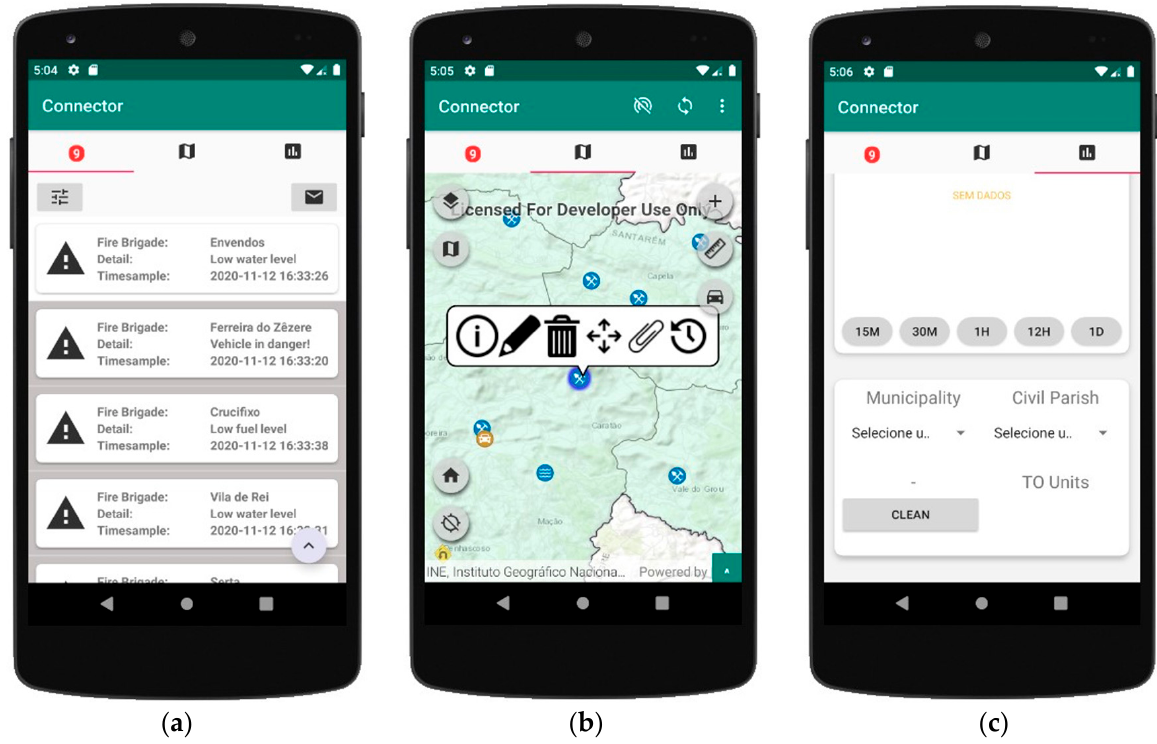
Figure 4. The mobile client application UI with three tabs: ( a ) the alerts area; ( b ) the map area; ( c ) and the data visualization area.